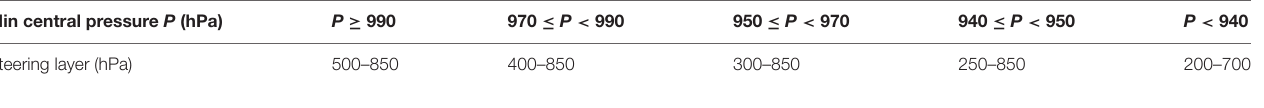
TABLE 1 | TC central pressures and its corresponding steering